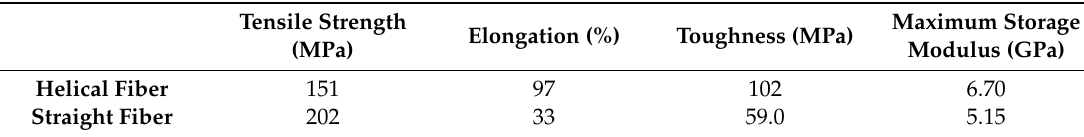
Table 3. Mechanical properties of nanomats composed of helical TPU/Nomex fibers (side-by-side) or straight TPU/Nomex fibers [127].